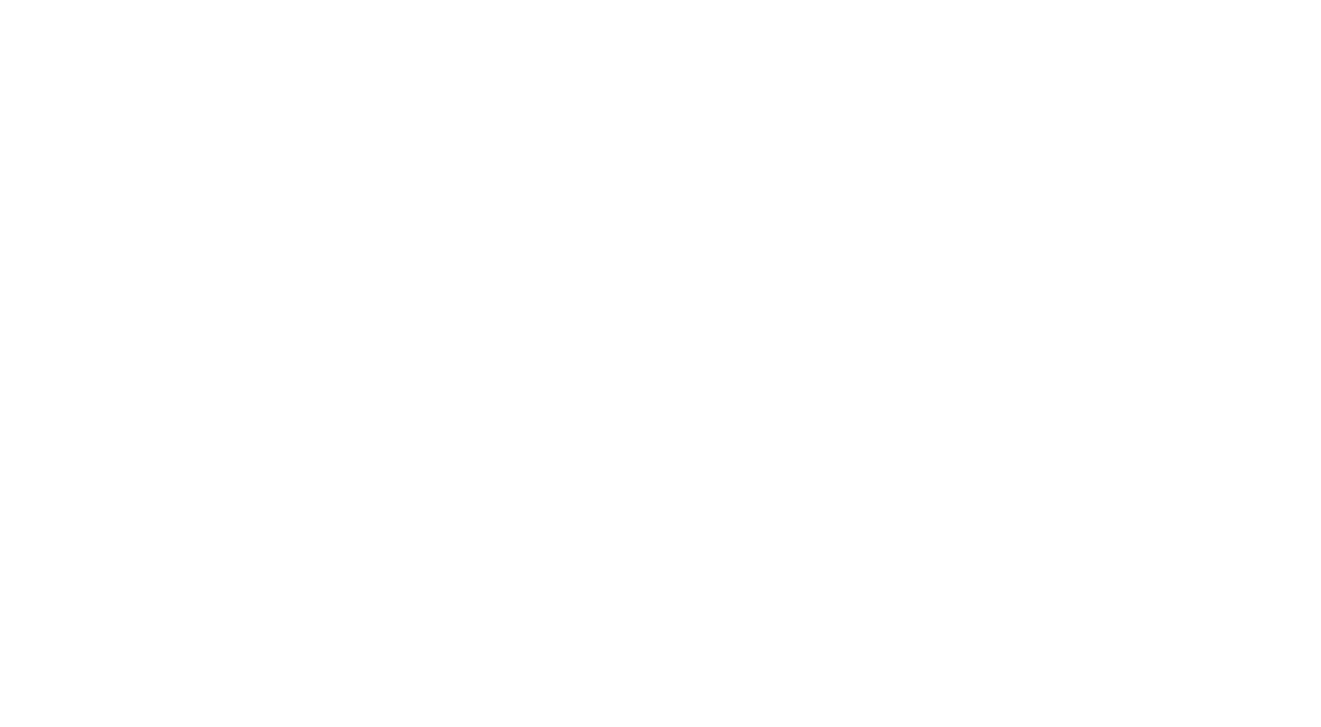
Frontiers in Agronomy |